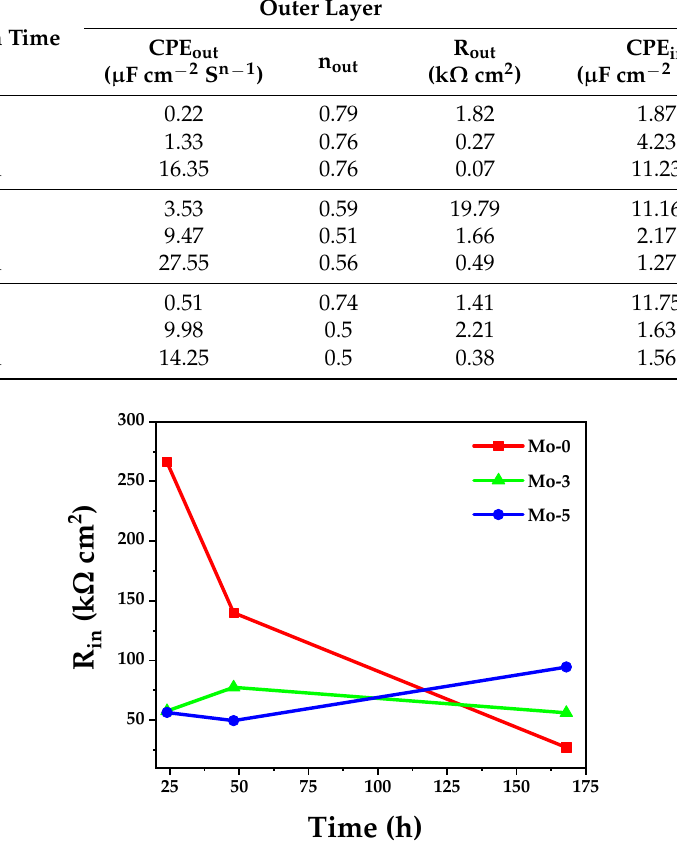
Figure 10. The variation of R in versus immersion time for the PEO coatings.